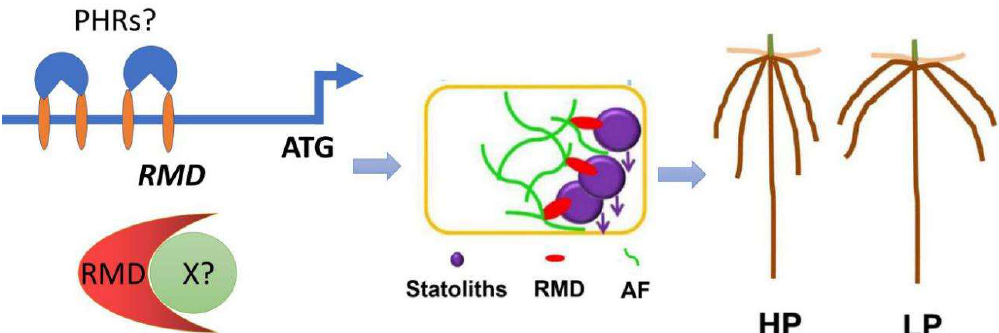
Figure 3. Proposed model for phosphate-dependent RMD-mediated regulation of RSA [12]. RMD links statoliths and actin filaments (AFs) in root columella cells, which is essential for RSA adaptation to di ff erent phosphorus conditions through fine-tuning gravitropism. RMD links statoliths and AFs in root columella cells which is essential for RSA adaptation to di ff erent phosphate conditions through fine-tuning gravitropism. There are 4 PHR1-like motifs among RMD promotor and which likely to be physically bound and activated by PHRs in rice. RMD-interacting proteins were necessary to elucidate the underlying mechanism in this response. In HP, the expression of RMD is lower, gravity-sensing process is enhanced and deep root system was shaped. In LP, the expression of RMD is